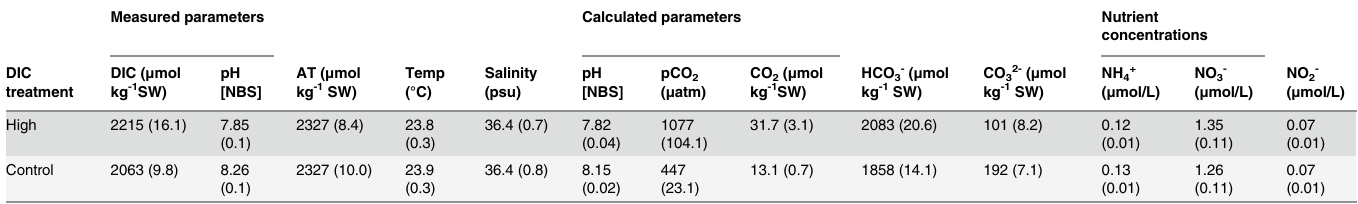
Temperature and pH readings in the aquaria tanks were measured with a hand held pH probe calibrated on the NBS scale. Dissolved inorganic carbon (DIC) and total alkalinity (AT) concentrations were measured from water samples taken every four days from each aquaria tank. Carbonate system parameters were calculated using USGS CO2calc software [43]. Average values and S.D. (in brackets) were